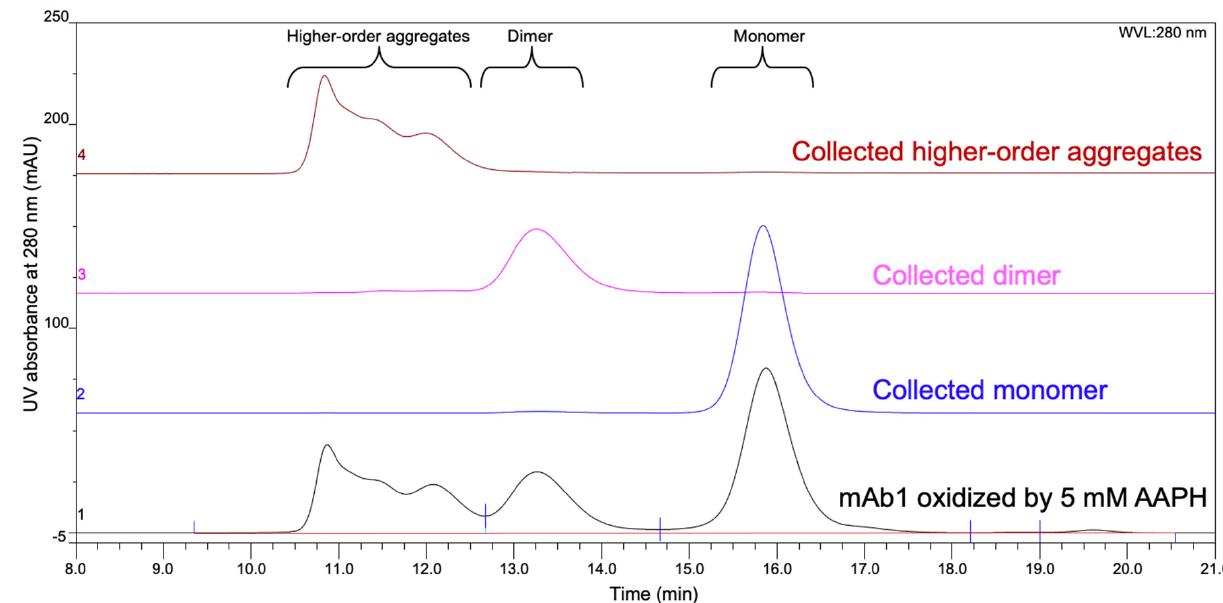
Figure 2. SEC of the collected fractions of mAb1 oxidized by 5 mM AAPH. Chromatogram 1: before fraction collection; chromatogram 2: re-injected monomer fraction; chromatogram 3: re-injected dimer fraction; chromatogram 4: re-injected higher-order aggregates